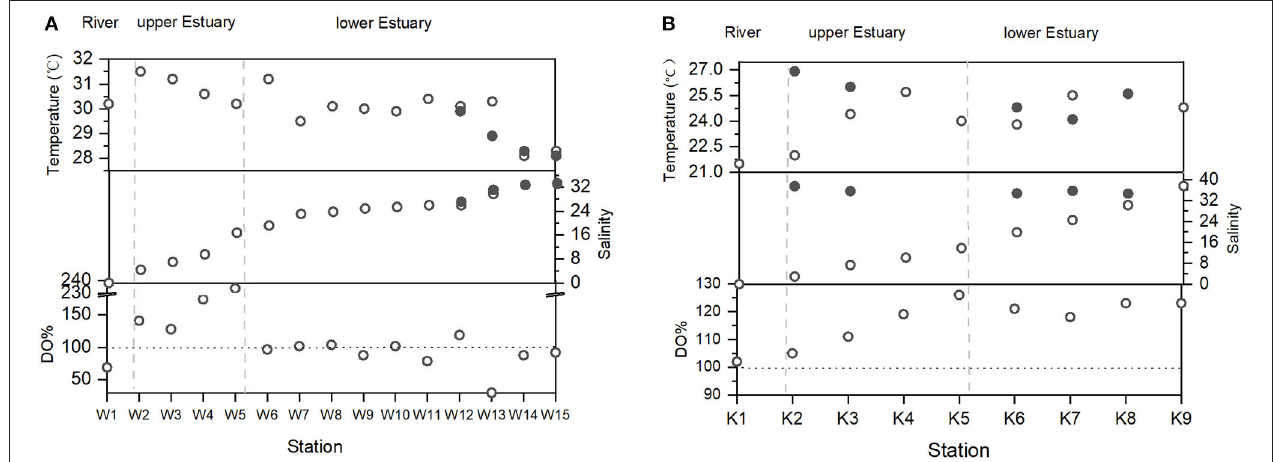
FIGURE 2 | Variations of temperature, salinity, and DO in (A) the WRE and (B) the KRE. White circles: surface; black circles: bottom layers.